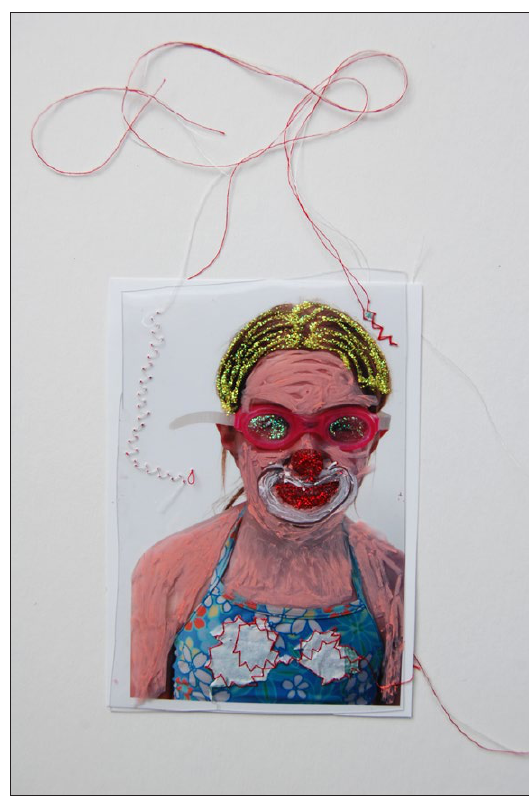
Figure 4: Brain Candy: Clown Face,